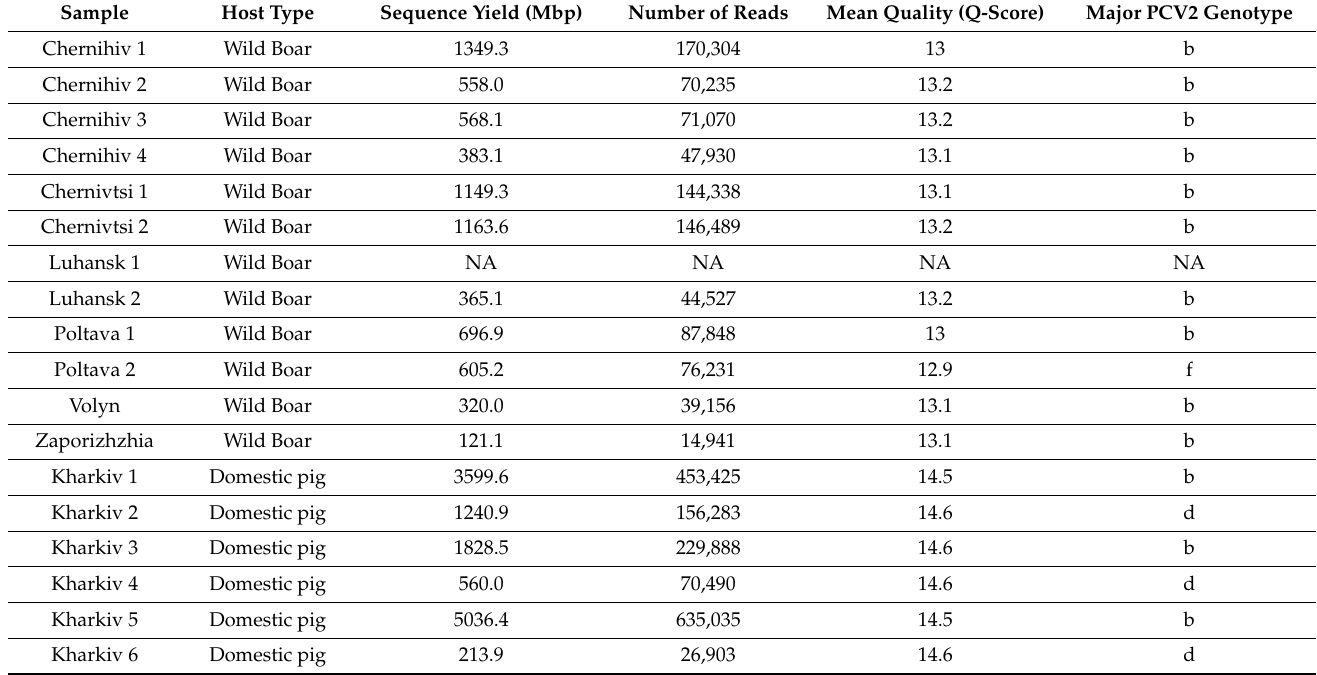
Table 2. PCV2 ORF2 capsid gene (Cap) amplicon sequencing